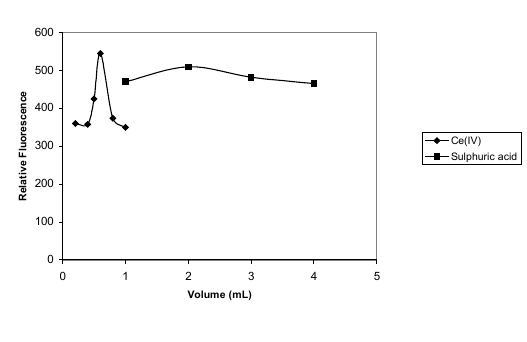
Figure 4. Effect of volume of Ce(IV) (1×10 -3 M) and sulphuric acid (1 M) on the fluorescence of Ce(III) with 0.24 μg mL -1 PNC.